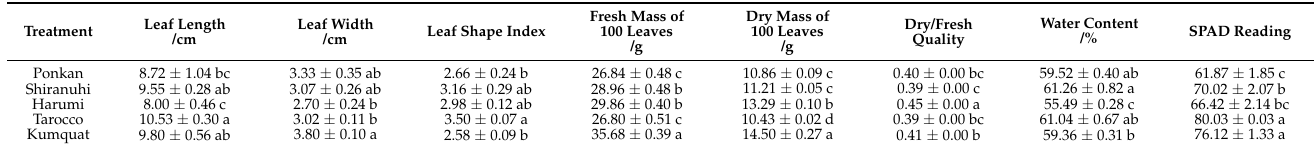
Table 3. Effects of different interstocks on the external morphological characteristics and leaf quality of